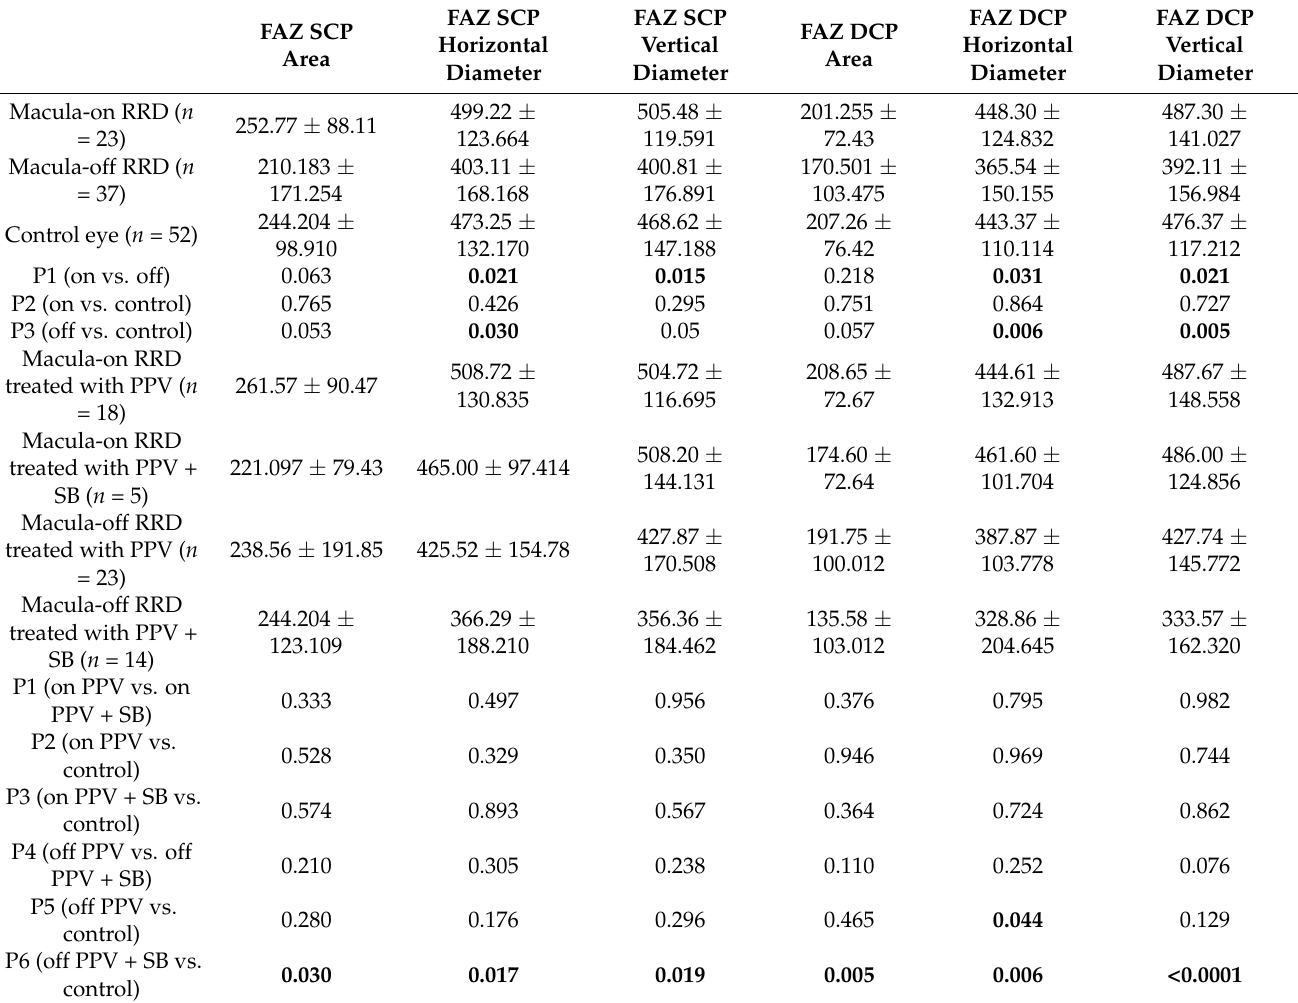
Table 3. Foveal avascular zone area (FAZ) in mm 2 and diameters in mm measured in both retinal capillary plexuses; eyes that underwent retinal surgery for rhegmatogenous retinal detachment vs. control